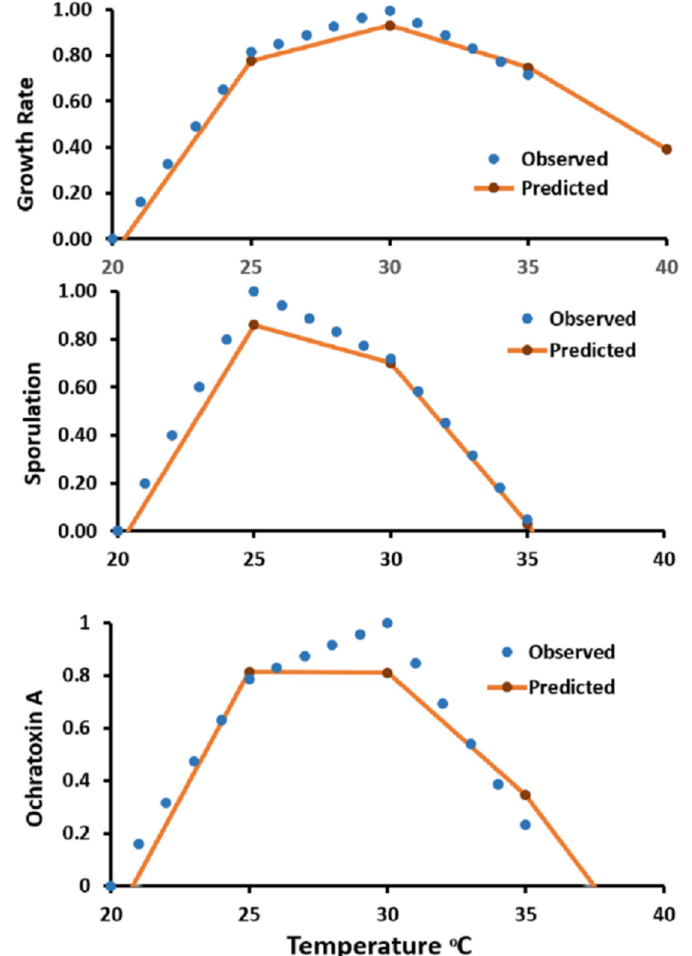
Figure 7. Comparison between observed and predicted values of growth, sporulation, and ochra- toxin A of A. westerdijkiae IBT 10738 in relation to temperature at 0.95 a w on a YES medium.